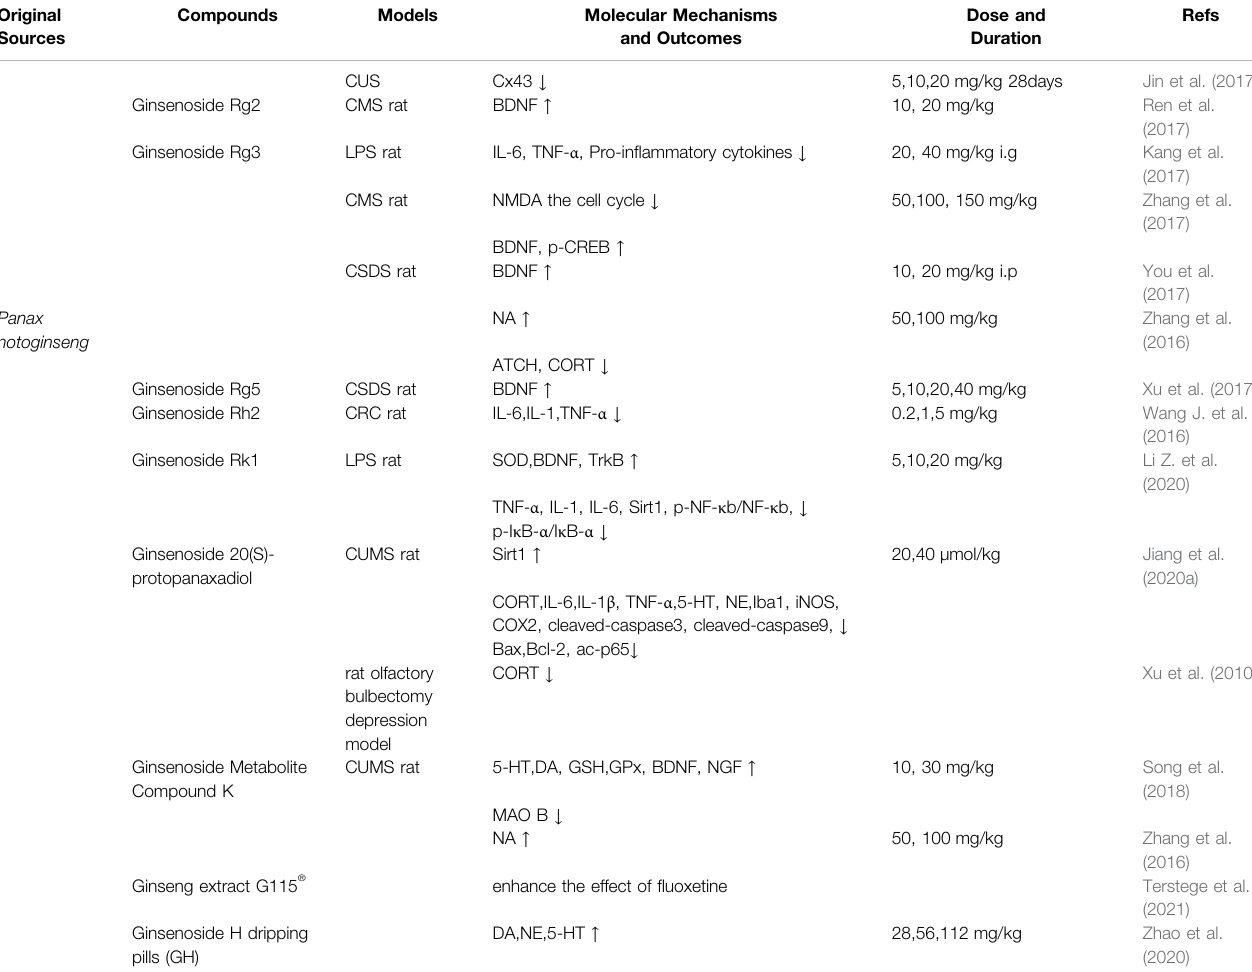
TABLE 1 | ( Continued ) The illustration of molecular mechanisms and outcomes of activated Panax notoginseng